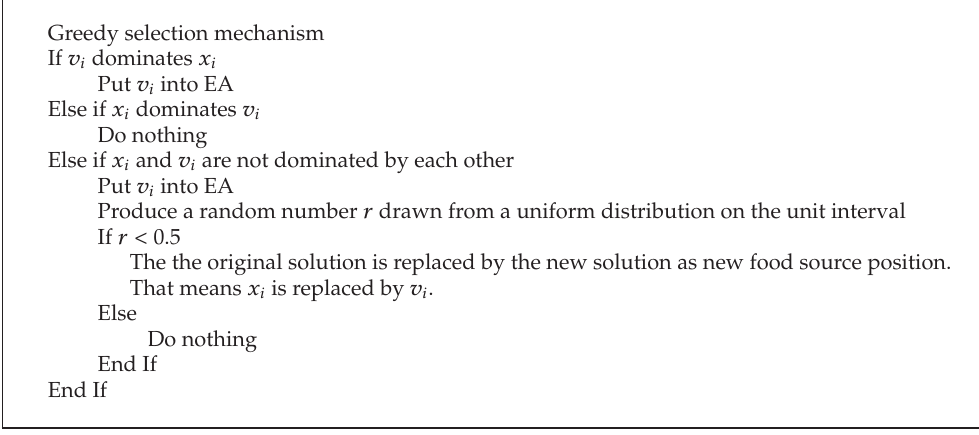
Algorithm 3: Greedy selection mechanism.